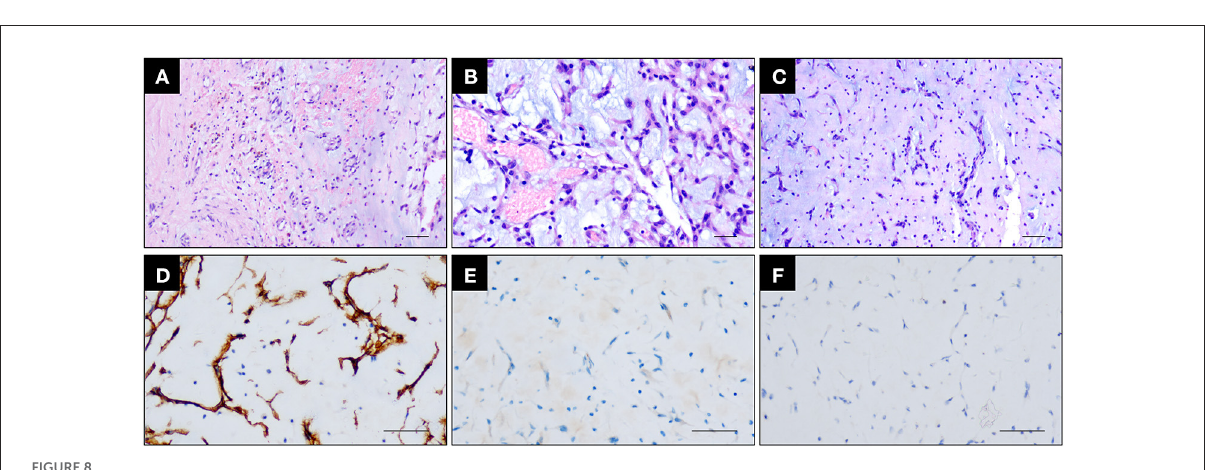
cerebral site: Figure 4D, cardiac site: Figure 8D), which is not express by myxofibrosarcoma cells. However, these cells do not express the smooth muscle marker SMA or Desmin (Figure 8E). Proliferation index of myxoma cells in this case is very low, i.e., around 1% (Figure 8F). Taken together, we exclude the diagnosis of myxofibrosarcoma as a differential